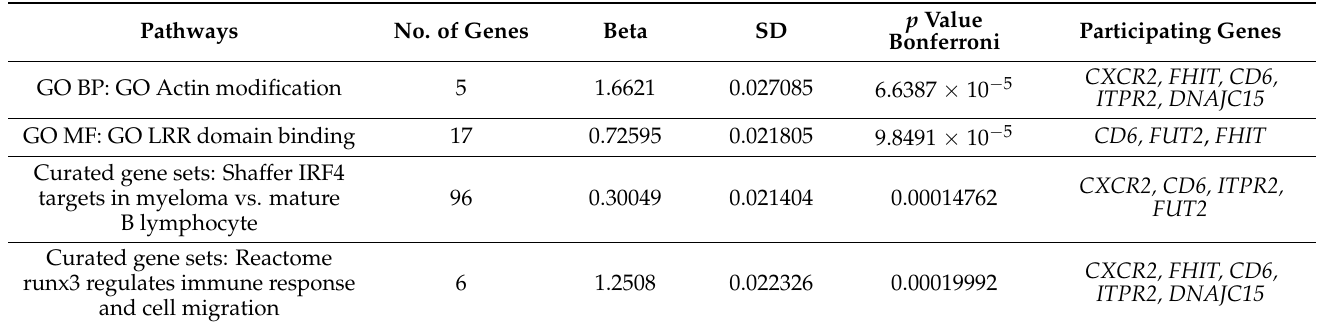
Table 4. Pathways related to genetic variants for duodenal ulcer risk.